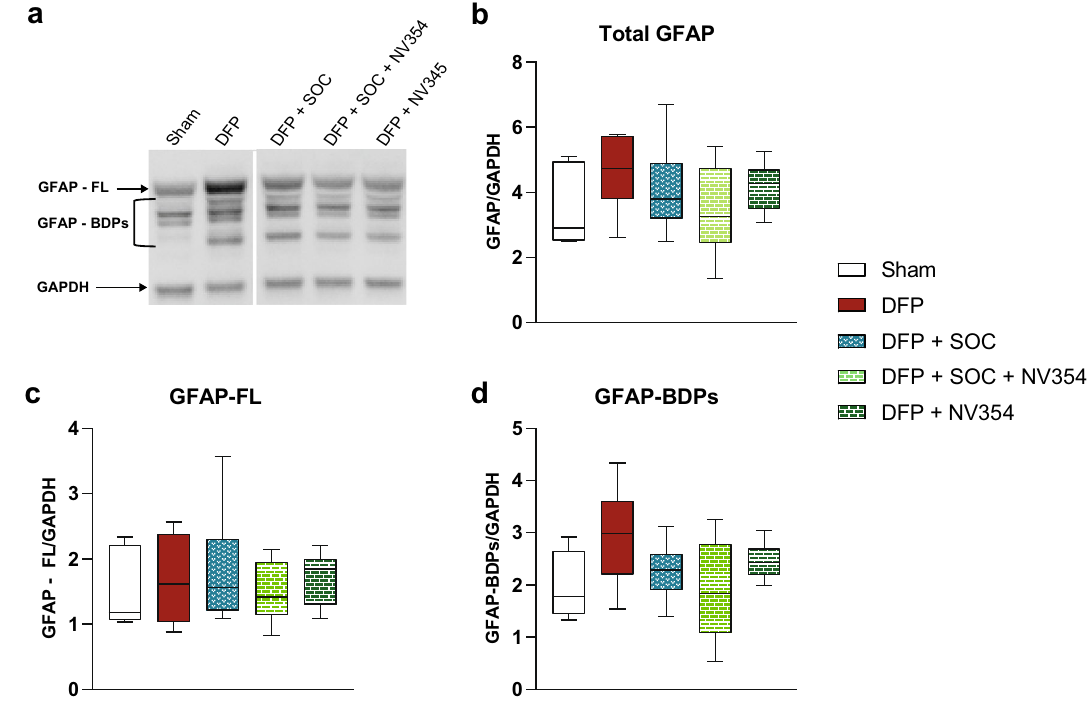
Figure 4. Brain injury markers. Levels of Glial Fibrillary Acidic Protein (GFAP), a biomarker indicative of brain injury, were measured with western blot following exposure to diisopropylfluorophosphate (DFP) with and without standard of care (SOC) treatment and the cell-permeable succinate prodrug NV354 (NV354). ( a ) Representative western blot image to illustrate full-length (FL) GFAP and its Breakdown Products (BDPs). The image was cropped to improve clarity and conciseness. A representative, original and unprocessed image is presented in Supplementary Fig. S7. Quantification of ( b ) total GFAP levels, ( c ) levels of GFAP-FL and ( d ) GFAP-BDPs. Data are presented as median plus interquartile range, with whiskers indicating minimal and maximal values. Kruskal–Wallis test or One-Way ANOVA was applied for analysis of differences of non- normally distributed and normally distributed data, respectively, with Tukey’s multiple comparison test of every group to every other group. n = 6–7 per